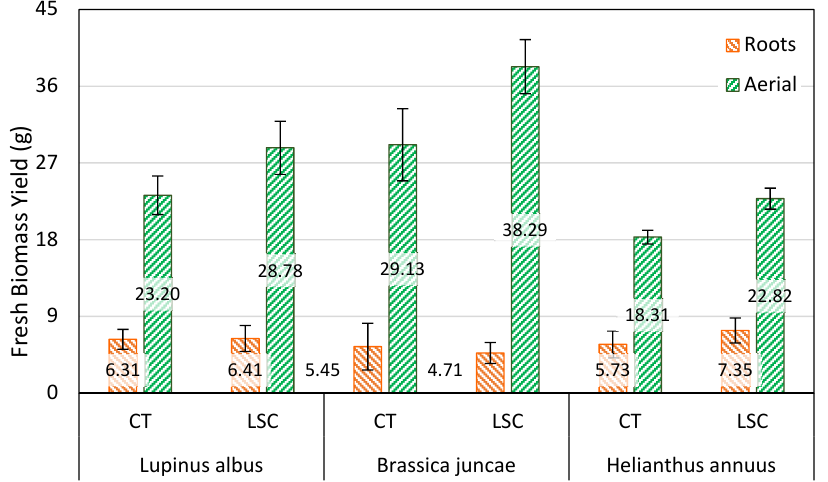
Figure 7. The yield of the biomass (g) of the five microcosms for each species. Data refer to the fresh weight of shoots and roots. Values are reported as mean ± standard deviation.